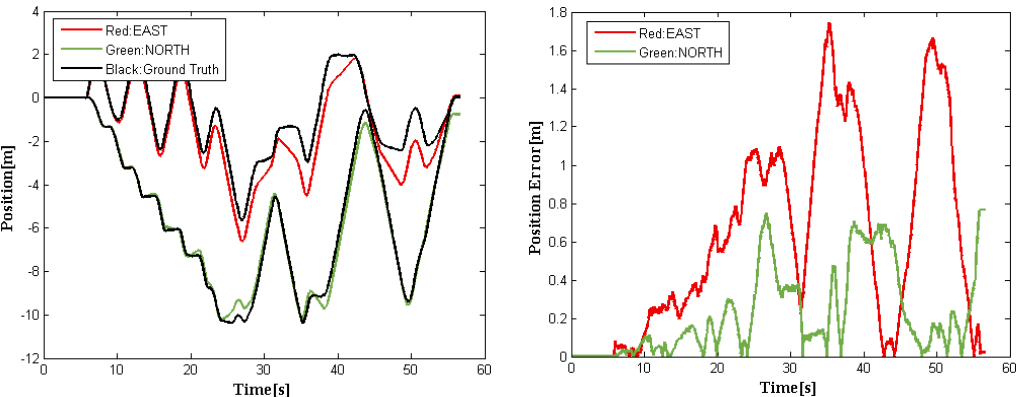
Figure 8. The corrected position ( Left ) corresponding to the trajectory in Figure 7. Errors in position are obtained as the norm of difference between the ground truth and our fusion data at each time-step ( Right ). Table 2. Performance comparison of our method with the nonlinear model (NLM) in [15].